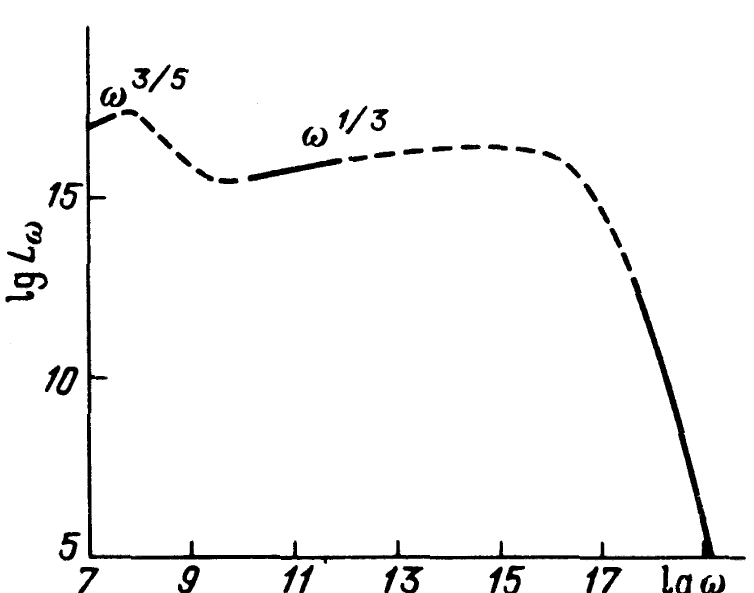
Figure 3. Magneto-bremsstrahlung spectrum of a BH of M = 10 M (cid:12) for a spherically symmetric accretion and random magnetic field at ρ ∞ = 10 − 24 g · cm − 3 , T ∞ = 10 4 K, α 2 = 1/3. The solid lines represent asymptotic dependencies, dashed lines give extrapolations, from Reference